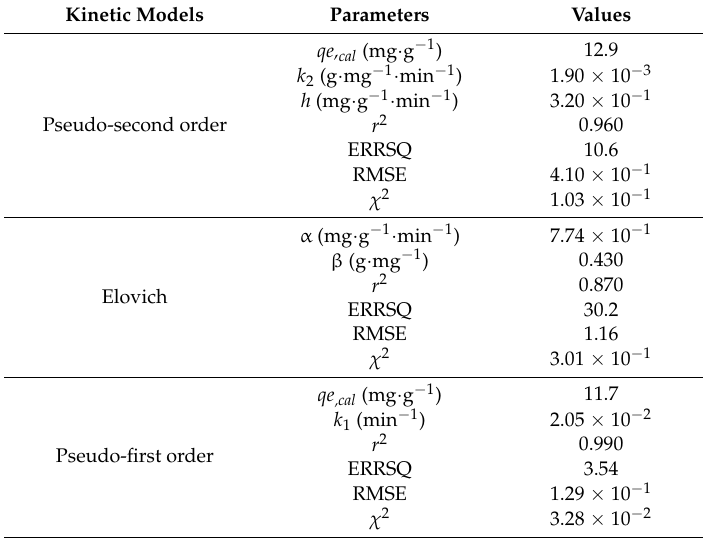
Table 5. Kinetic modelling parameters for cadmium sorption on